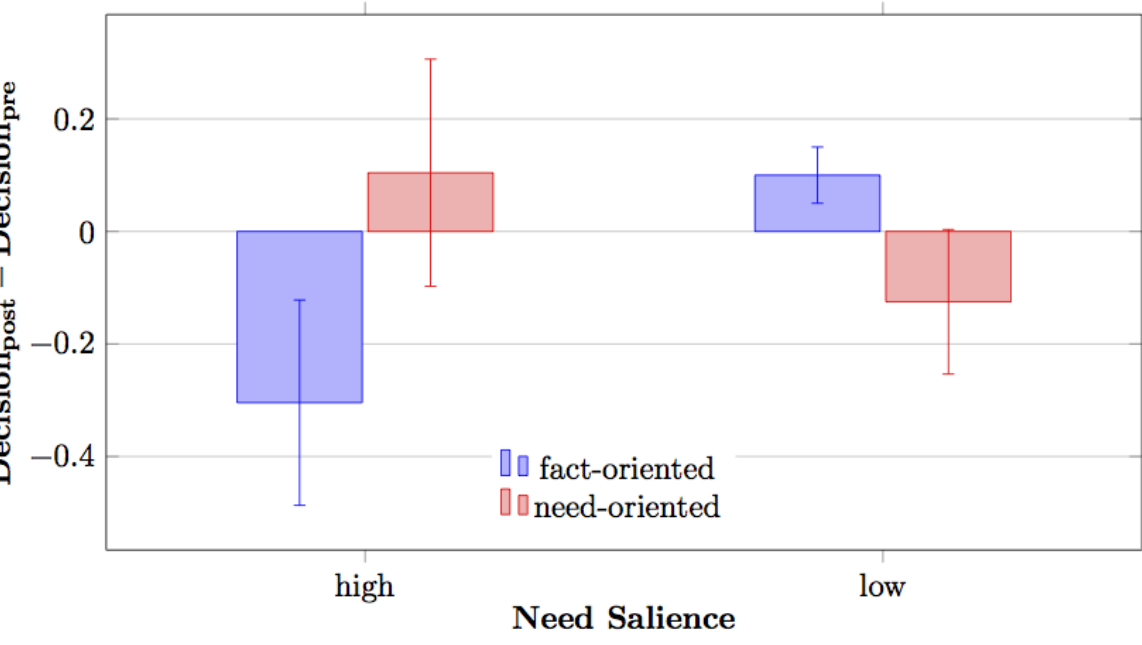
Figure 2. Interaction effect between communication style and need salience regarding decision modification. Standard errors are represented by error bars attached to each